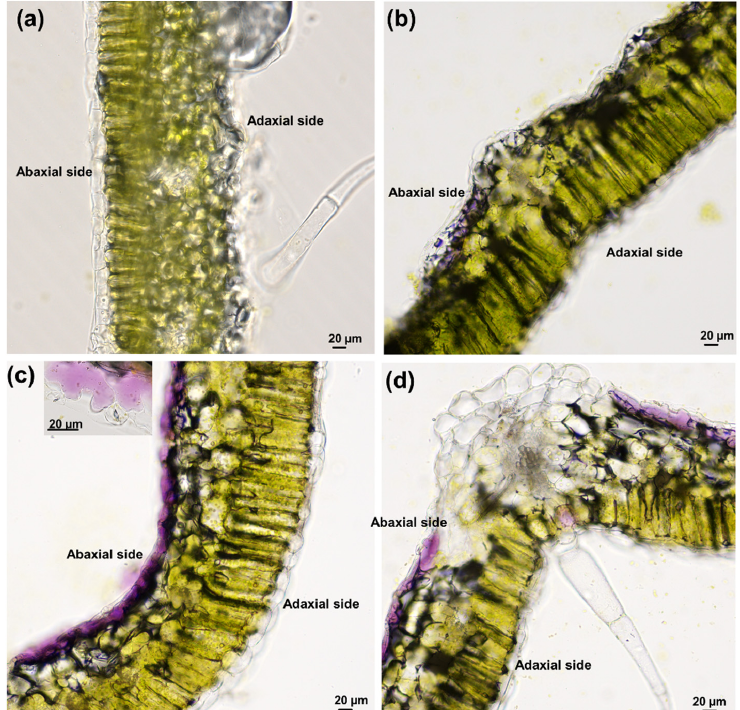
Figure 2. Vibratome section of a representative leaflet from ( a ) control; ( b ) 100 mM NaCl; ( c ) 200 mM NaCl; ( d ) 400 mM NaCl. A dark purple coloration appeared on the abaxial side of the NaCl-treated plants. Inset in c: detail of a jigsaw puzzle-like epidermal cells showing a purple color. Vibratome sections of Micro-Tom stems showed the effects of salt on the vascular tissue. Figure 3 shows indeed a less developed xylem tissue, an altered thickening of the vascular tissues and a reduction of the vessels’ diameter at the highest concentration.